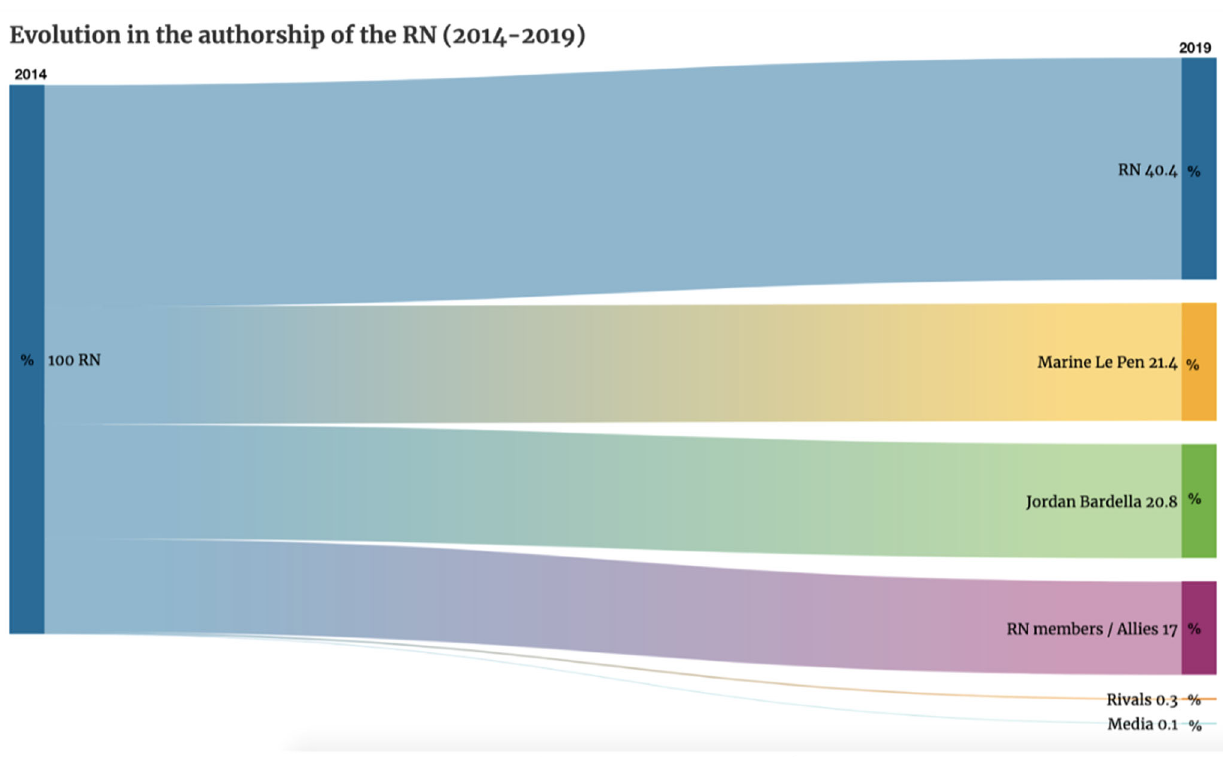
Fig. 2 Evolution in the authorship of the RN (2014 – 2019)/Own